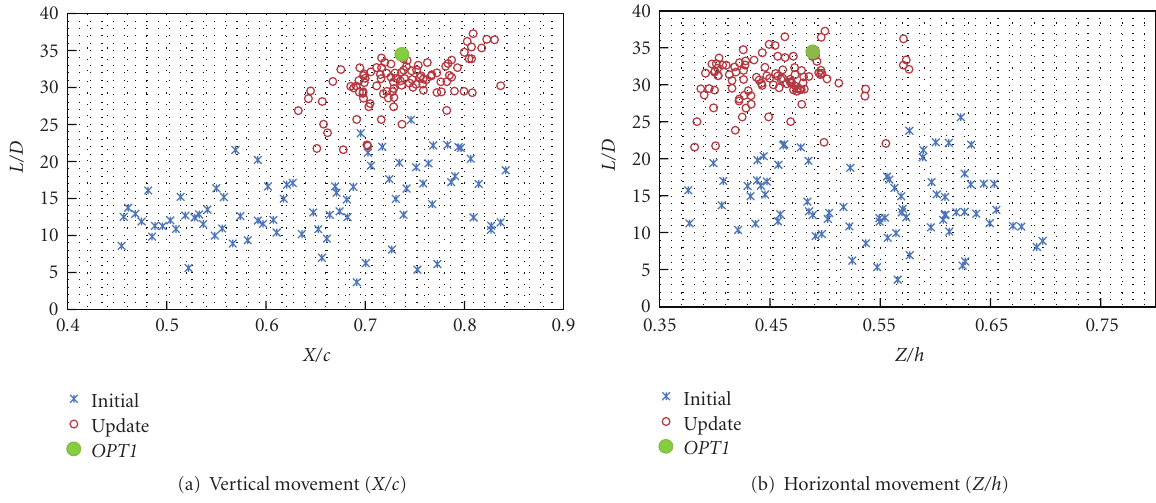
Figure 12: L/D distribution against nacelle position (blue: initial samples, red: update points).